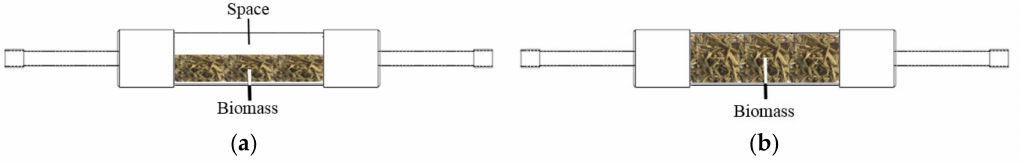
Figure 4. Two types of biomass bulk arrangement. ( a ) Hollow bulk arrangement; ( b ) Compact bulk